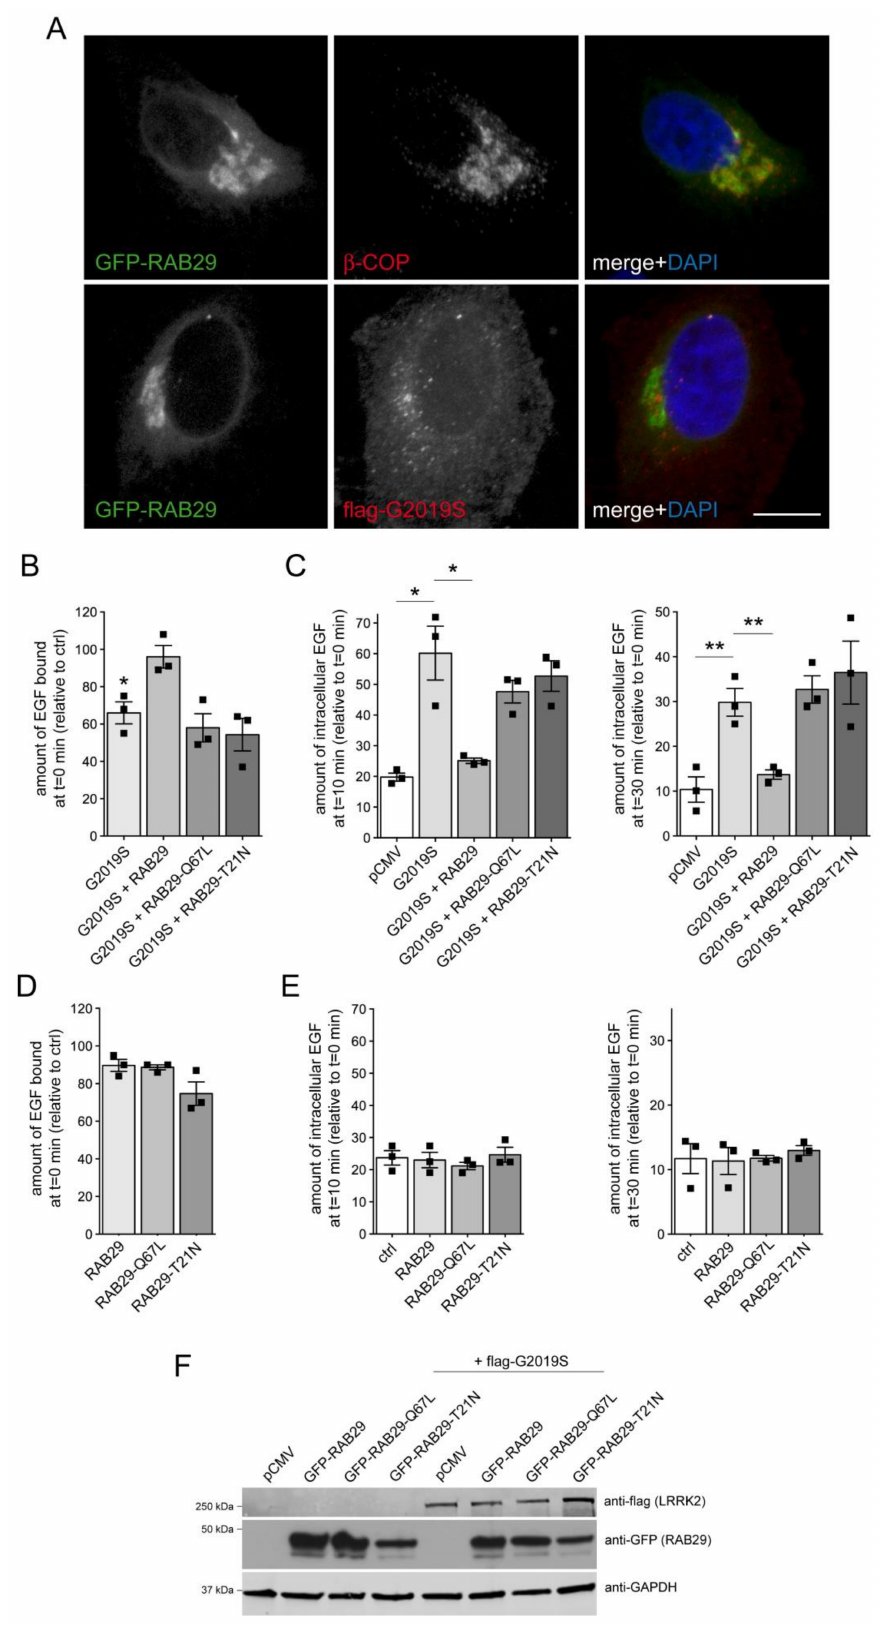
Figure 5. RAB29 rescues the G2019S LRRK2-mediated EGF trafficking deficits. ( A ) Top: Example of HeLa cell transfected with GFP-tagged RAB29 using Lipofectamine 2000 (LF2000), and stained with